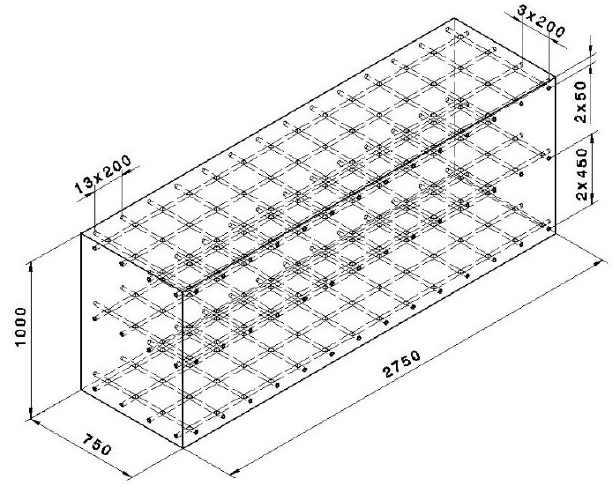
Figure 2. Target geometry with measurements in mm and a reinforcement diameter of 20 mm.